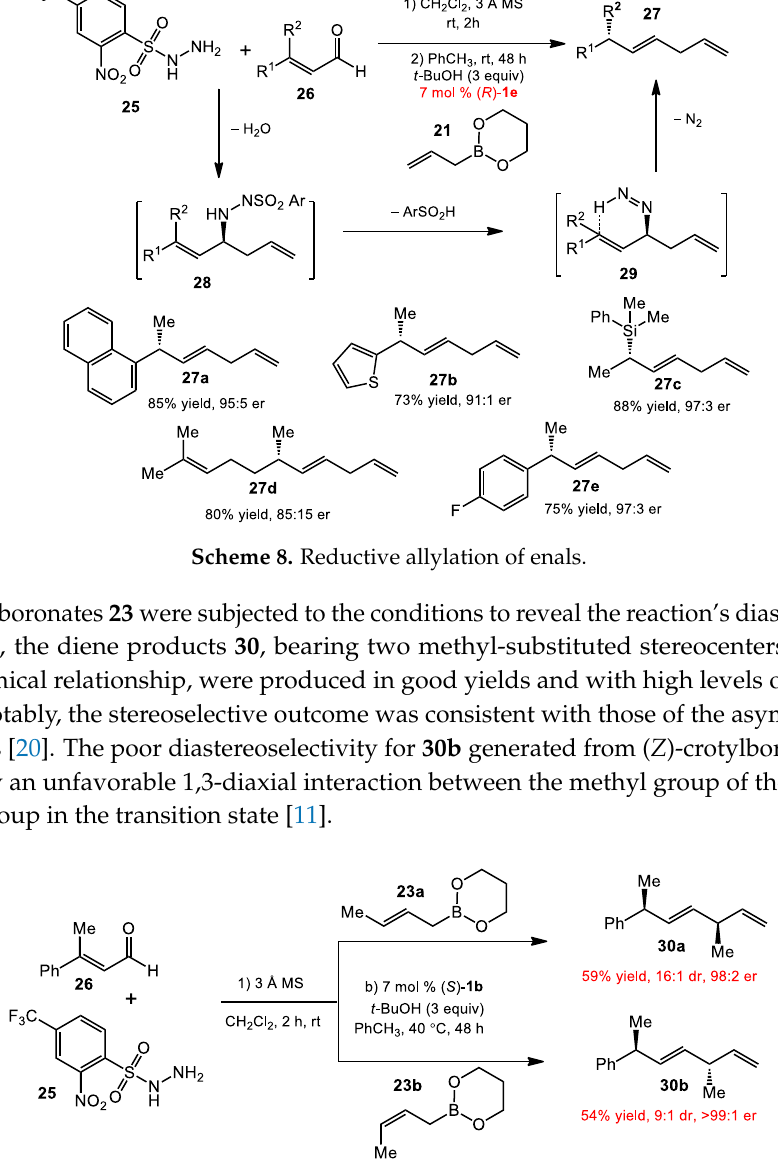
Scheme 9. Diastereoselective reductive crotylations.